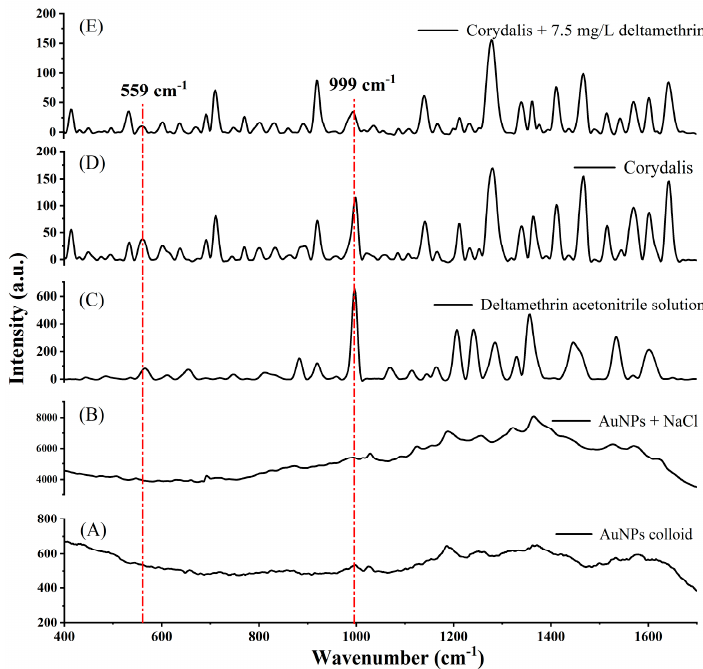
Figure 2. Selection of Raman characteristic peaks for detection of deltamethrin in Corydalis . ( A ) Raman spectrum of AuNPs colloid; ( B ) Raman spectrum of AuNPs with NaCl; ( C ) SERS of deltamethrin acetonitrile solution; ( D ) SERS of Corydalis extract; ( E ) SERS of Corydalis extract with 7.5 mg/L deltamethrin.